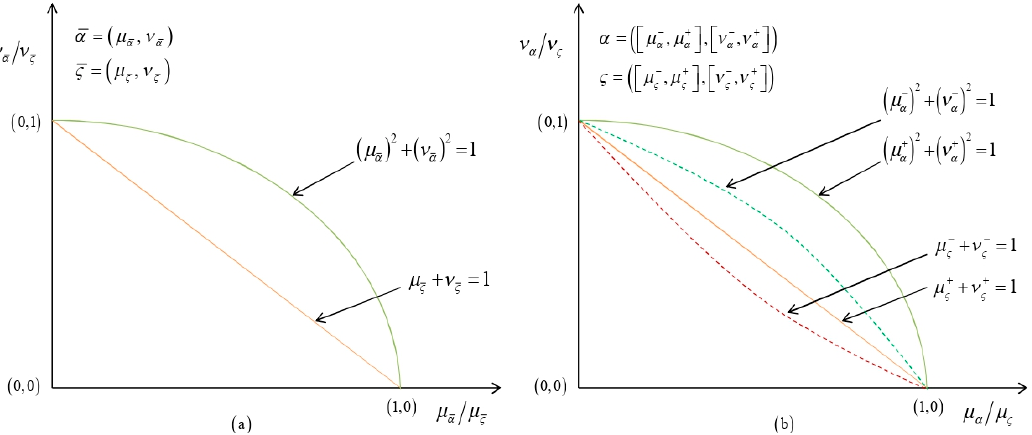
Figure 1. Geometrical representations of IF/IIFNs and PF/IPFNs with spaces of ( a ) IFNs and PFNs, ( b ) IIFNs and IPFNs.